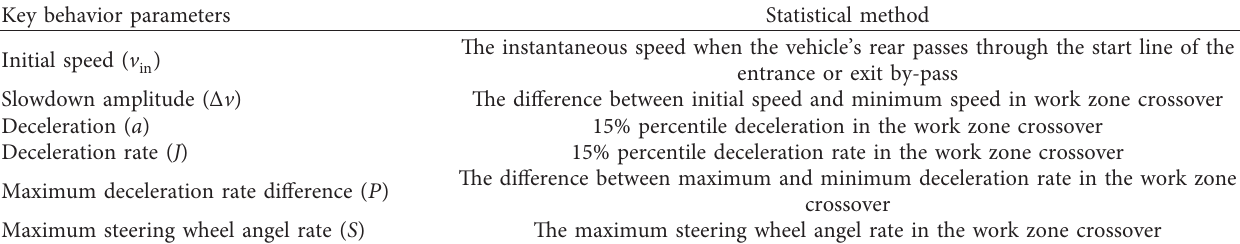
Table 3: Statistical method of key behavior parameters.